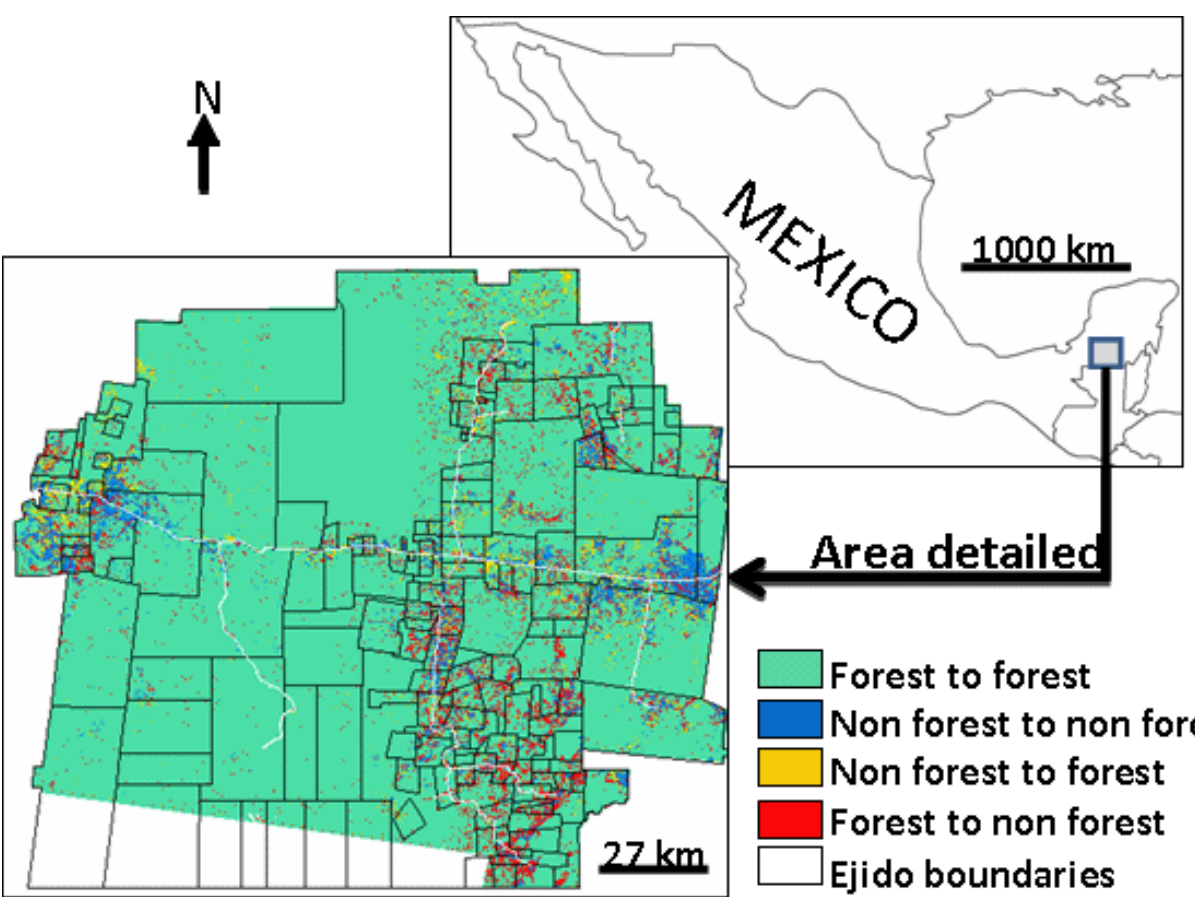
Fig. 1. Land use changes in the study region (adapted from Roy Chowdhury 2006 a ,Turner et al. 2004). Polygons in the area-detailed inset represent boundaries of ejidos